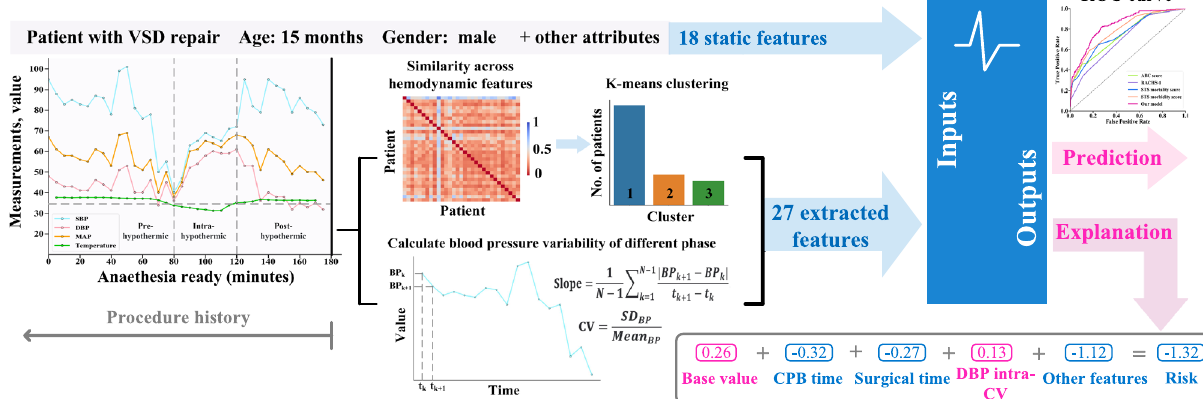
Figure 1. Schematic of data processing and workflow of our proposed model. We used soft-DTW to measure similarities of time-series hemodynamic data, and k-means clustering was applied to capture different